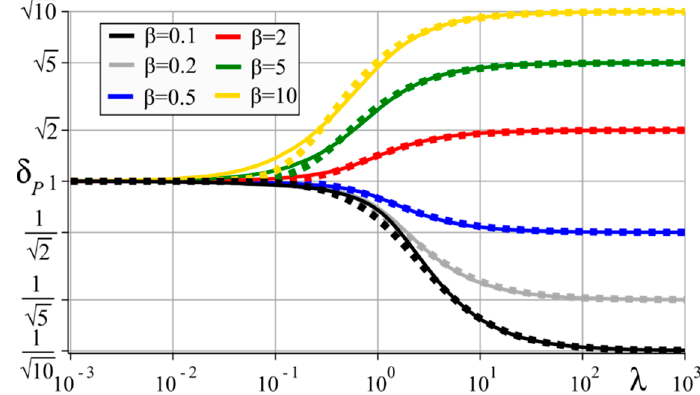
Figure 5. Relative indentation depth δ P for the homogeneous coatings calculated with N >> 1 (solid lines) and N = 1 (dashed lines).